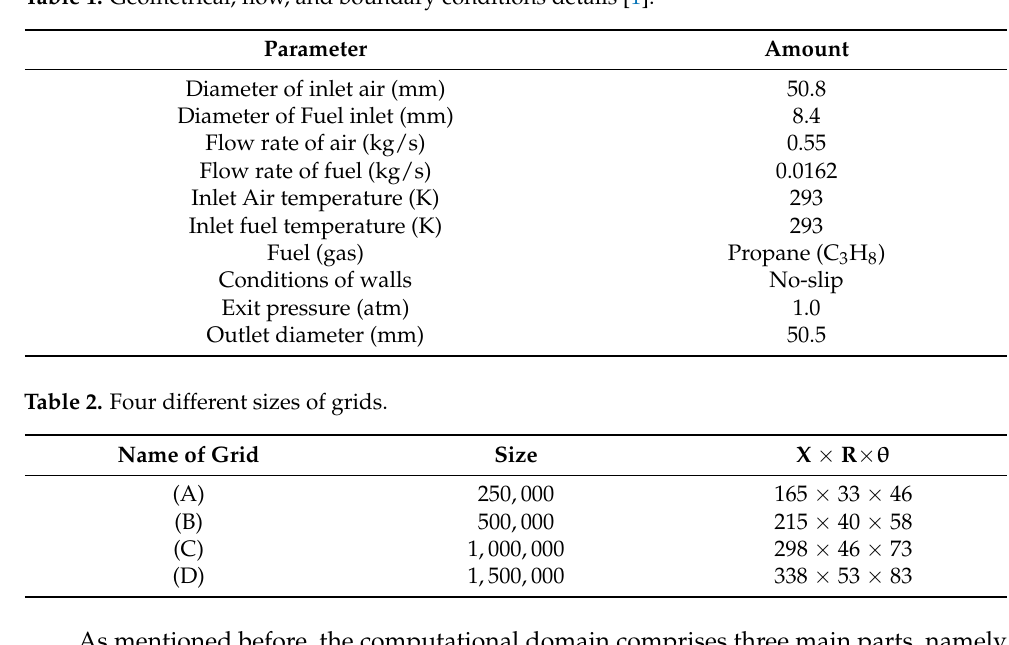
Figure 1. A schematic illustration of model combustor. Table 1. Geometrical, flow, and boundary conditions details [1].